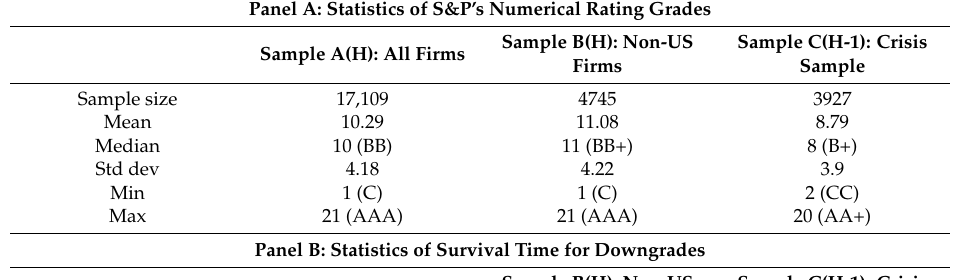
Table 2. Statistics of rating grades and survival